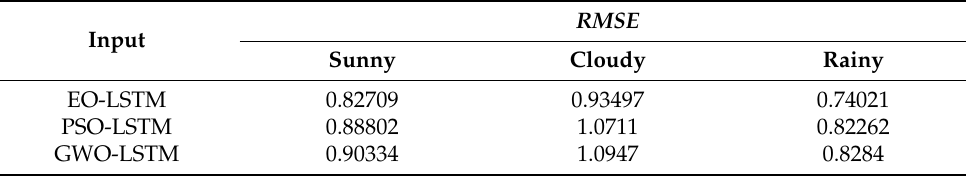
Table 7. RMSE of each optimization model under different weather